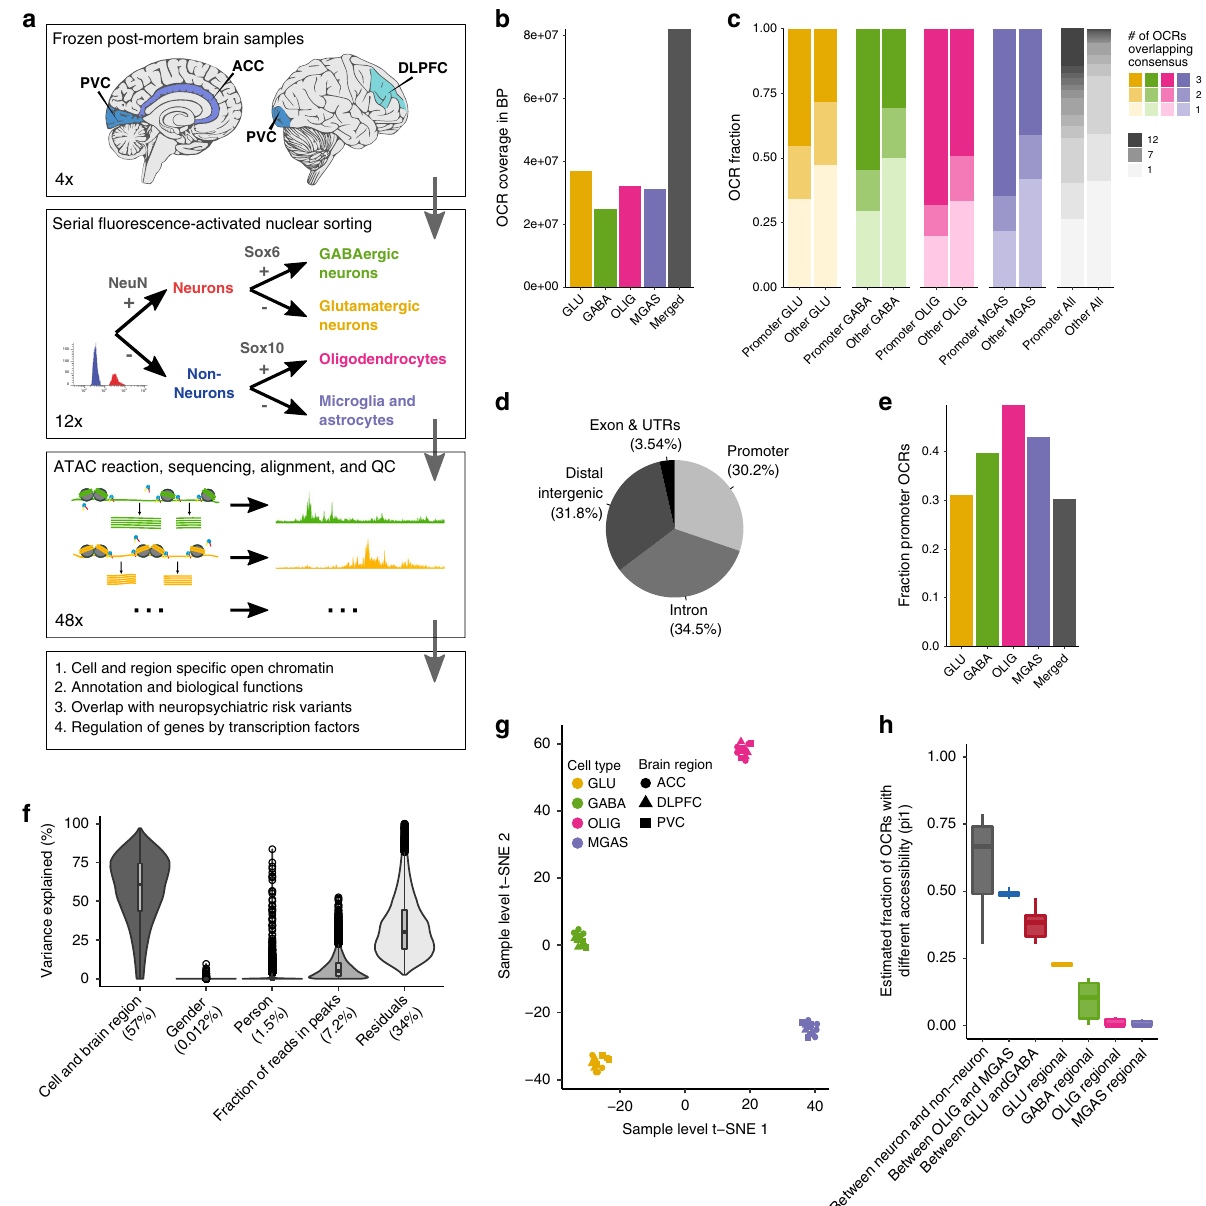
Fig. 1 Outline of study and chromatin accessibility across four cell types. a Study design: Dissections from three brain regions of four early adulthood control subjects were obtained from frozen human postmortem tissue (ACC: anterior cingulate cortex; DLPFC: dorsolateral prefrontal cortex; and PVC: primary visual cortex). Nuclei were subjected to fl uorescence-activated nuclear sorting to yield four-cell subpopulations, followed by ATAC-seq pro fi ling and subsequent downstream analyses to identify cell type-speci fi c open chromatin regions and differences in biology. b Genomic coverage in base pairs of identi fi ed OCRs by cell type. c Number of OCRs called per sample groups. For the individual cell types three overlaps mean that the OCR was detected in all three brain regions and for “ All ” 12 overlaps means the OCR was detected in all brain regions and cell types. d Genomic annotation of consensus OCRs. OCRs within 3 kb of a TSS were considered promoter OCRs. e Fraction of OCRs considered as promoter OCRs by cell type. f Violin plot that illustrated the proportion of variation in chromatin accessibility explained by biological and technical covariates. The fraction of reads in peaks can be considered a signal to noise parameter. Numbers in parentheses indicate median. g t-SNE clustering of chromatin accessibility using adjusted read counts in 47 independent samples. h Quanti fi cation of statistical differences between various cell types by brain region comparisons using the pi1 metric. The center shows the median, the box shows the interquartile range, whiskers indicate the highest/lowest values within 1.5x the interquartile range, and potential outliers from this are shown as dots. From left to right, the number of independent contrasts represented by each boxplot are: 54, 9, 9, 3, 3, 3, and 3. The pi1 estimates the proportion of non-null tests. The boxplot shows the pi1 estimate between the relevant sample groups. For instance, “ Between OLIG and MGAS ” are all pairwise comparisons of the three OLIG sample groups (ACC/DLPFC/PVC) and the three MGAS sample groups (ACC/DLPFC/PVC). OCR open chromatin region, GLU glutamatergic neurons, GABA GABAergic neurons, OLIG oligodendrocytes, MGAS microglia and astrocytes, ACC anterior cingulate cortex, DLPFC dorsolateral prefrontal cortex, and PVC primary visual